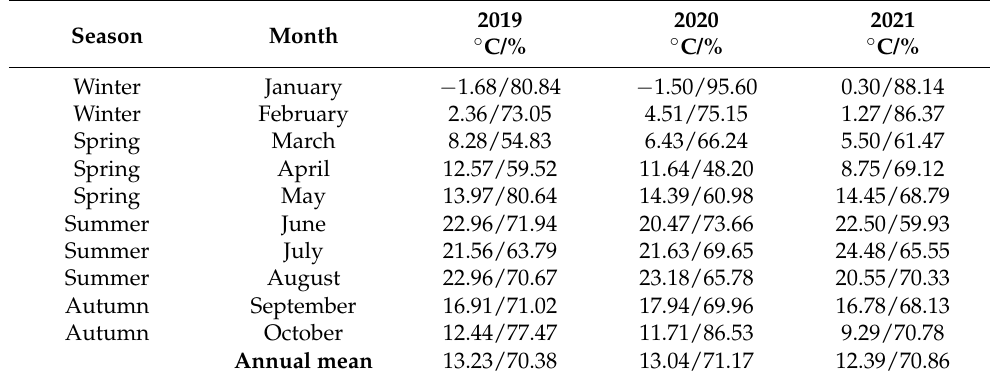
Table 2. The mean temperature ( ◦ C) and humidity (%) in the three examined years by seasons and